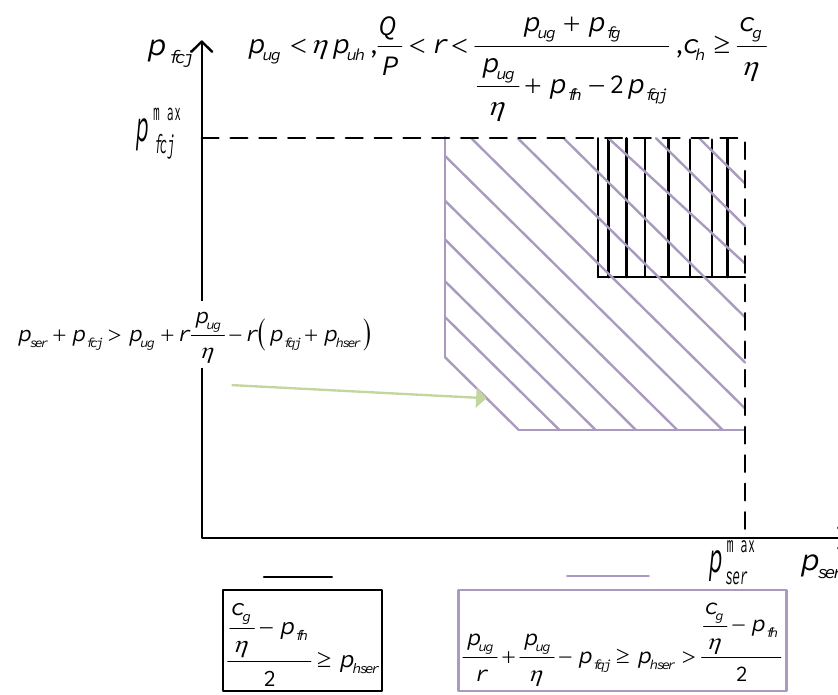
Figure A10. Scenario 10: two-dimensional sketch of the tripartite game Nash equilibria.